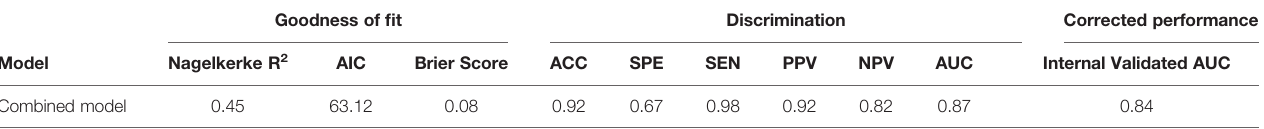
TABLE 3 | Performance of combined